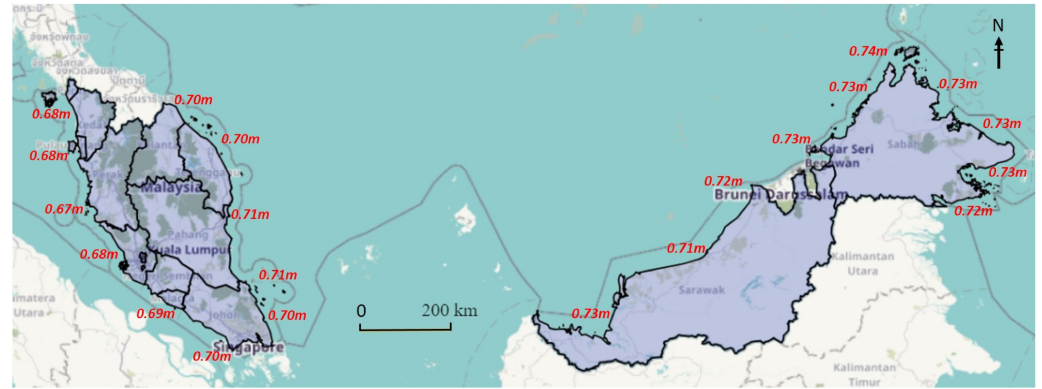
Figure 19. Map of the sea-level rise projection of Malaysia in 2100 based on RCP 8.5 [133]. Reproduced from Report on Impact of Climate Change: Sea Level Rise Projection in Malaysia, 2017; published by National Water Research Institute of